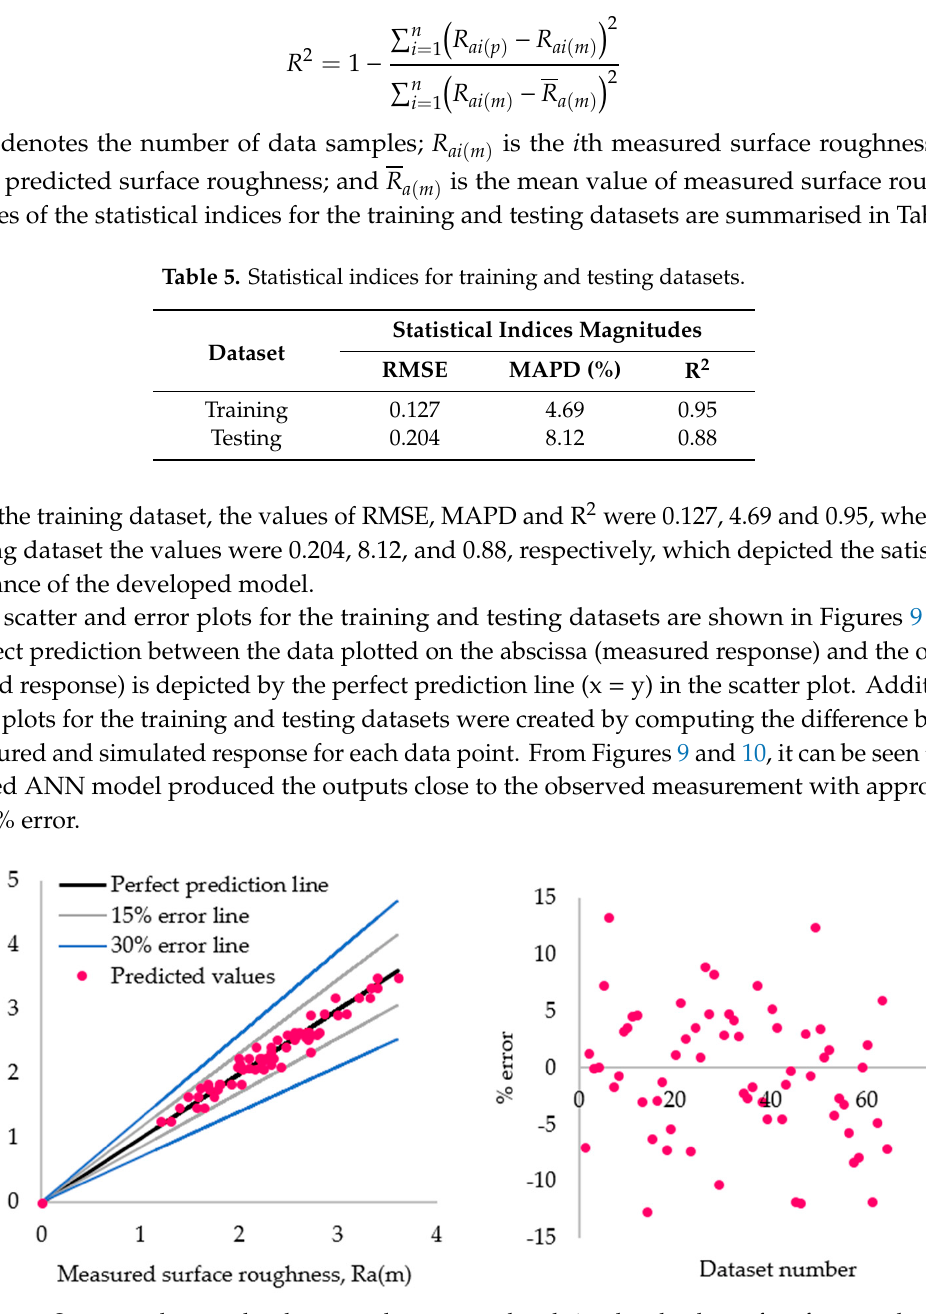
Figure 9. Scatter and error plots between the measured and simulated values of surface roughness for training.